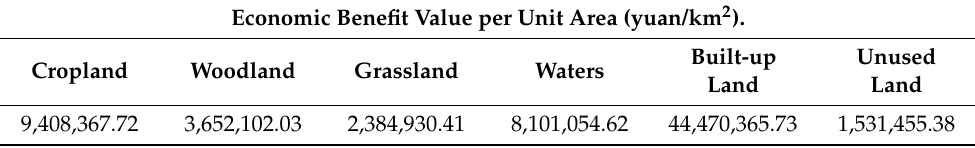
Table 1. Value of economic benefits per unit area of the Yellow River Basin from 1995 to 2018. Economic Benefit Value per Unit Area (yuan/km 2 ).